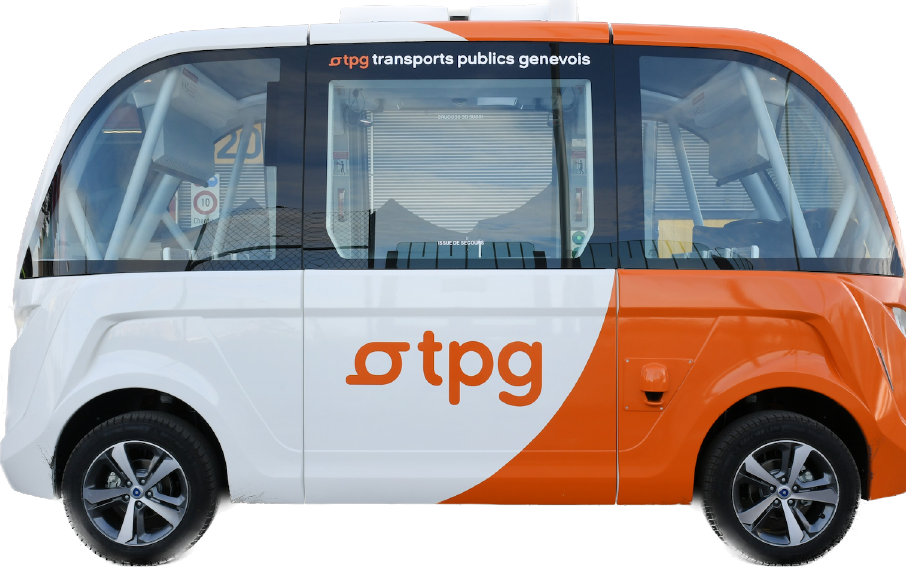
Figure 1. Example of the Automated City Shuttle investigated in the present